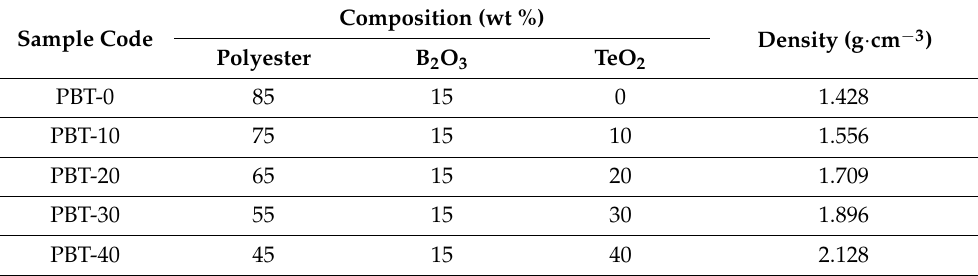
Table 1. Samples code, compositions, and